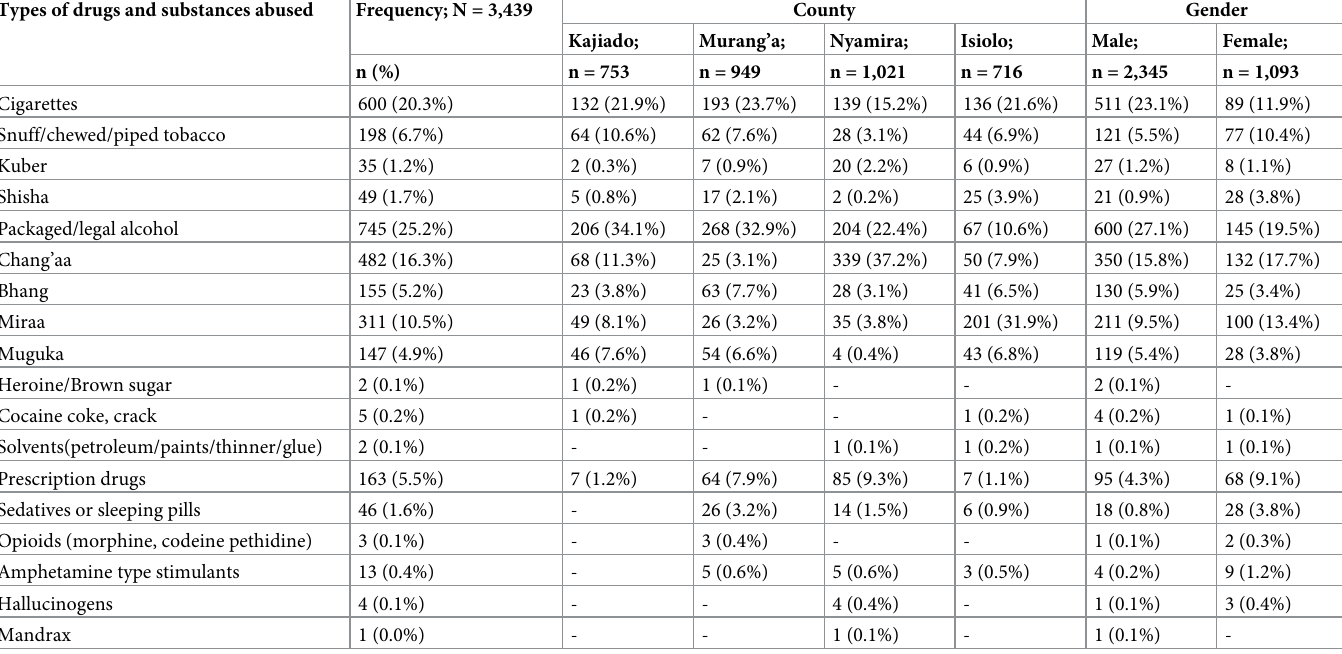
Table 3. Types of drugs and substances abused by respondents according to county and